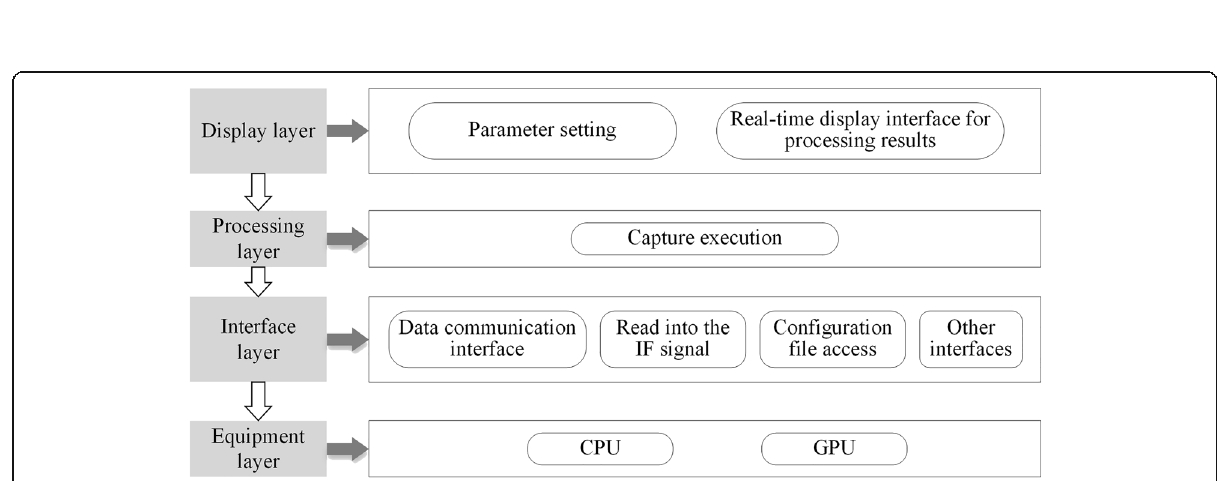
Fig. 4 Procedure of logical channel. The figure shows the processing process of the correlation energy accumulation and frequency domain capture of a logical channel in the system